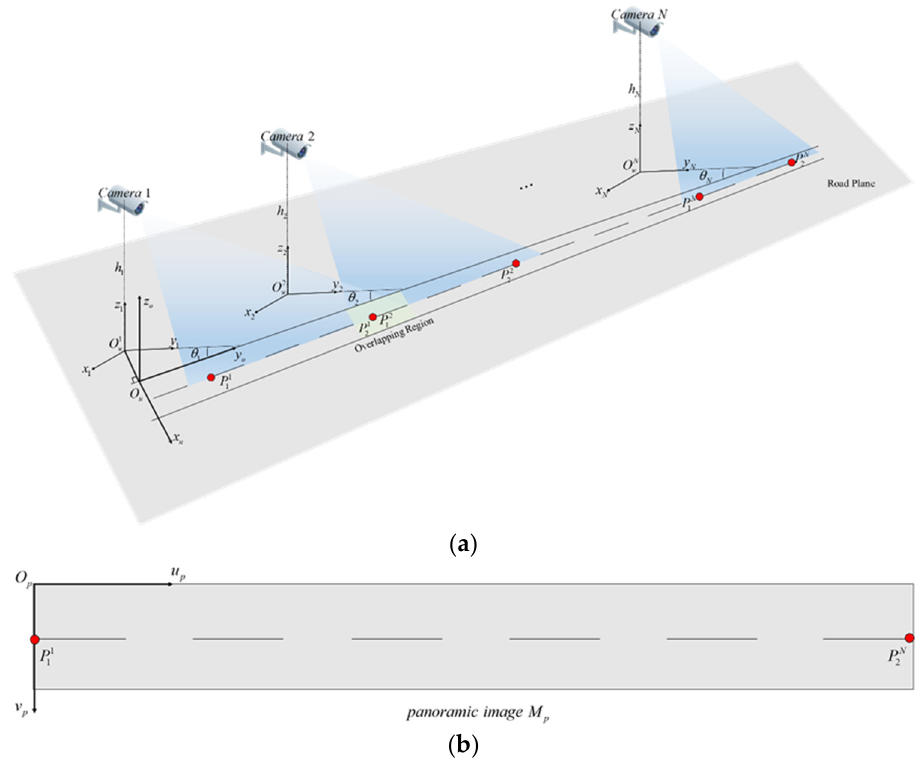
Figure 4. Schematic diagram of road space fusion in cross-camera scenes. ( a ) The unified world coordinate system; ( b ) The panoramic image of road space.